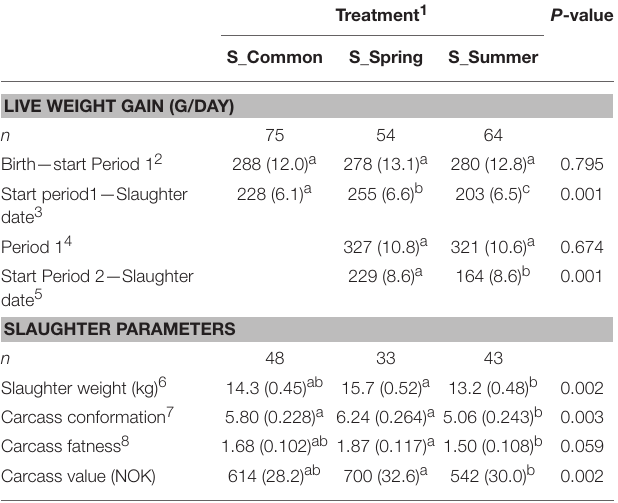
TABLE 4 | Effect of spring grazing treatment on lamb live weight gain, slaughter weight, carcass conformation, fatness and value (LSMeans with standard error of mean in brackets).